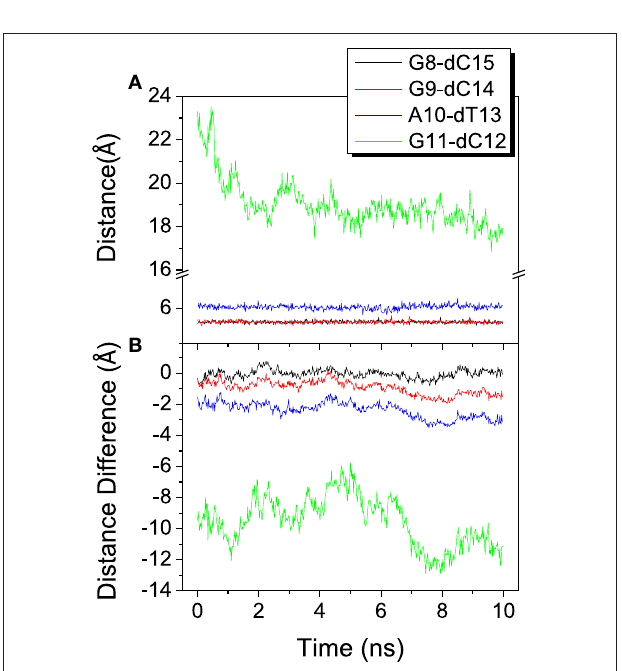
FIGURE 5 | Distance among the mass center of the polymerase and the last 4 base pairs of the DNA/RNA hybrid. (A) Distance between each base pair. (B) Distance difference for each base pair, calculated from distance of RNA to protein minus that of DNA to protein. contacts in the simulation of six trajectories are also shown in Figure 7 . Two stable hydrophobic interactions can be found: Ala832-dT13 and Ala828-G11, with populations higher than 30%. Figure 7 also shows two hydrogen bonds with populations higher than 30%. These hydrogen bonds are between residues Arg839 and Watson-Crick edge of dC14. Comparing among these three kinds of interactions, electrostatic interactions is in predominance, which suggests that the electrostatic interactions